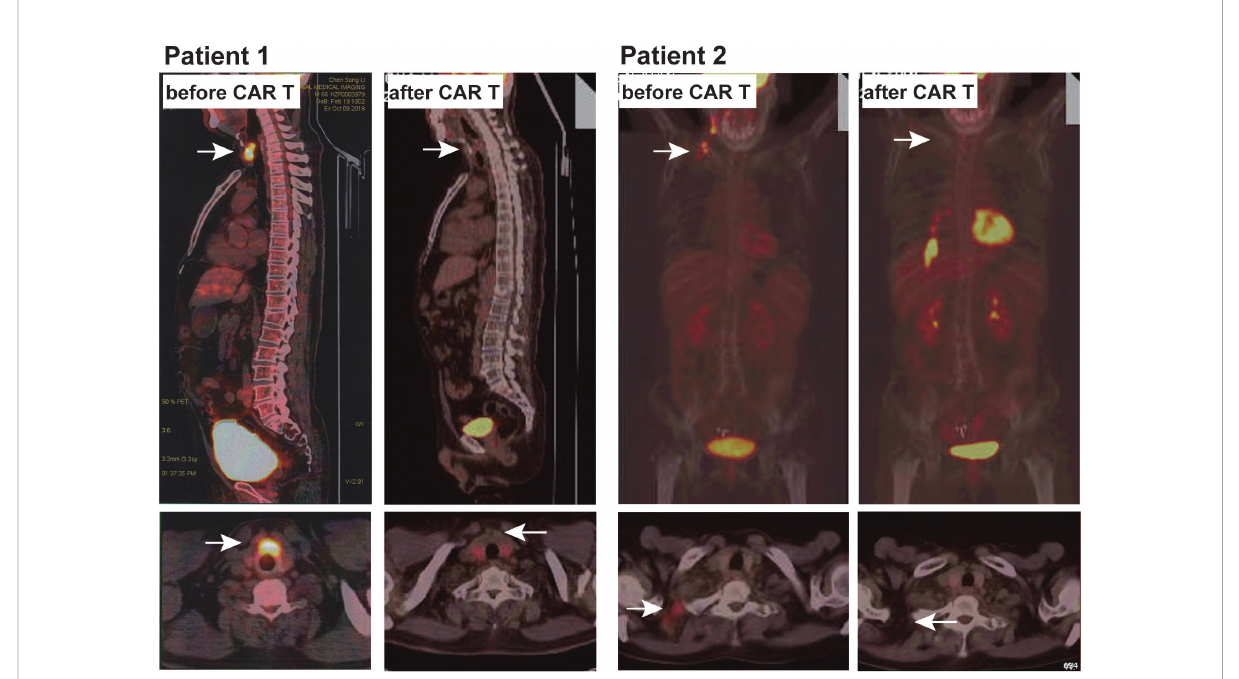
FIGURE 1 PET-CT images of two patients before and after CART